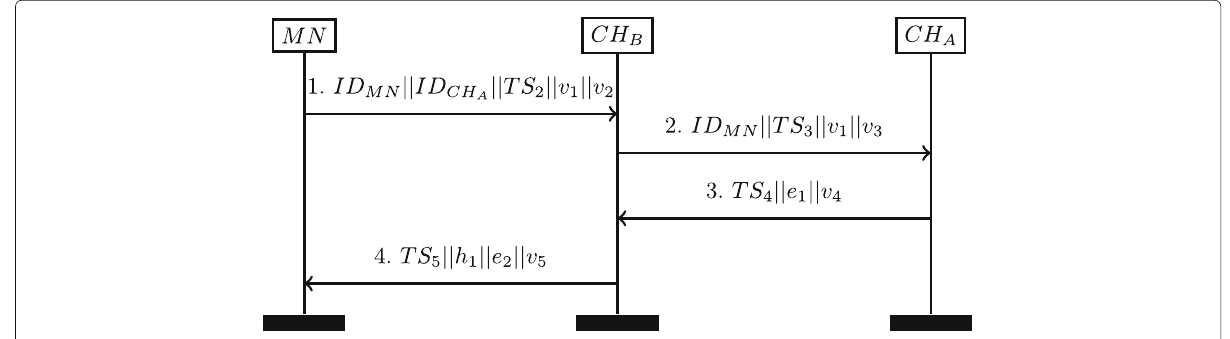
Fig. 3 Overview of node reauthentication